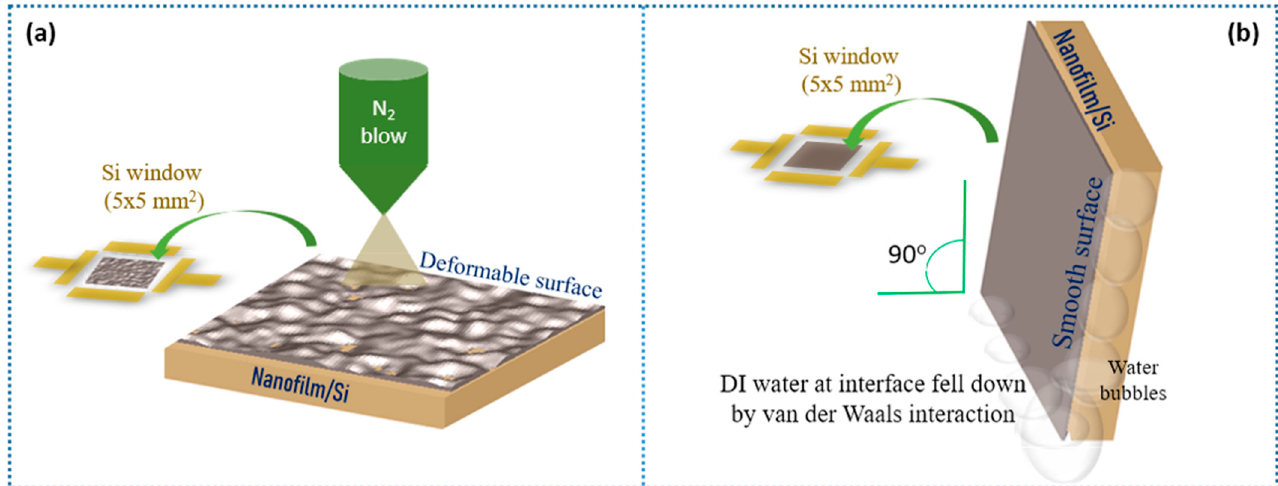
Figure 1. ( a ) Cross-sectional TEM image of the as-fabricated nanofilm. Two transfer methods of the nanofilm onto Si via ( a ) isopropanol (IPA) injection and N 2 blowing (deformable surface) and ( b ) deionized (DI) water injection and van der Waals (vdW) interaction (smooth surface).